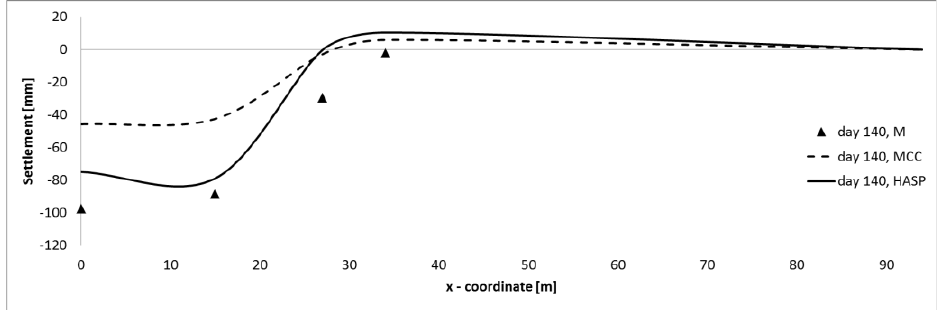
Figure 22. Comparison of the settlement of the ground surface for Embankment B — day 140.